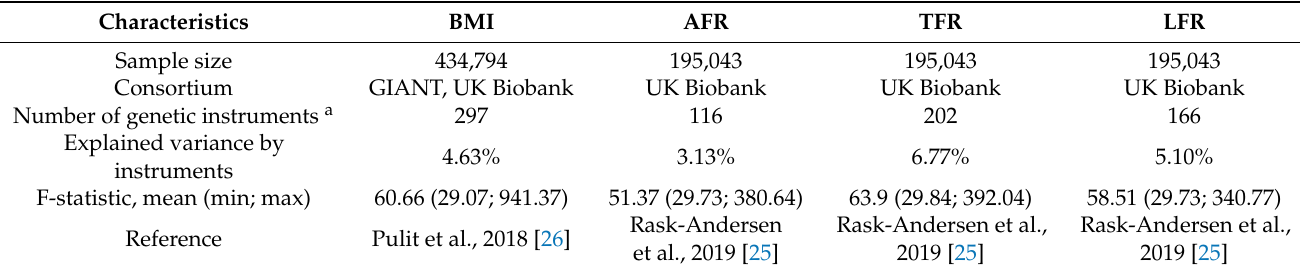
Table 1. Overview of genome-wide association studies used in the analyses for the exposures and characteristics of the Single Nucleotide Polymorphisms (SNPs) considered as instrumental variables. Characteristics